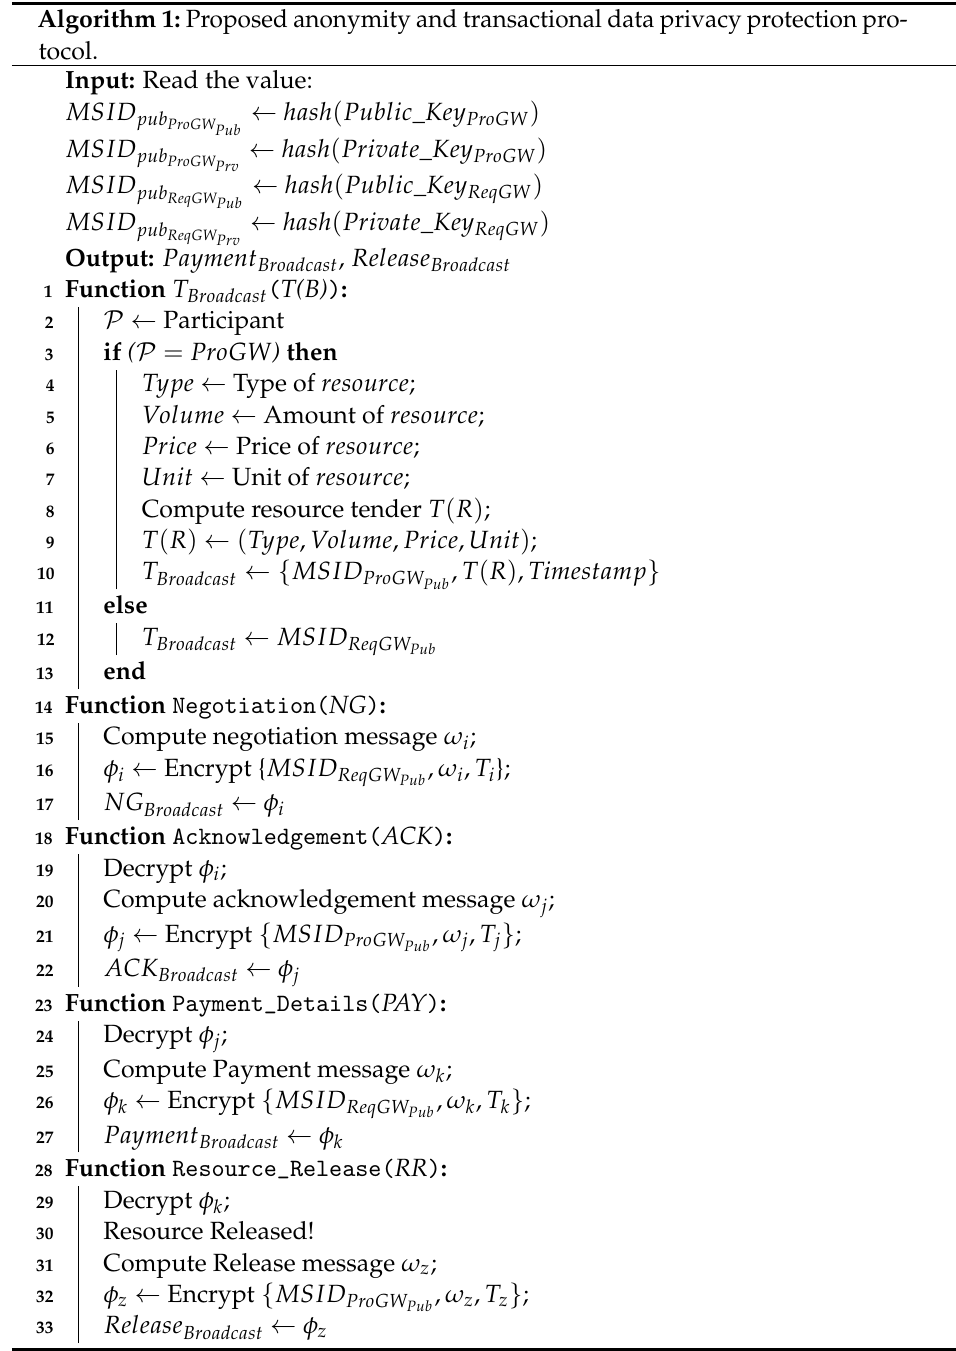
Algorithm 1: Proposed anonymity and transactional data privacy protection pro-